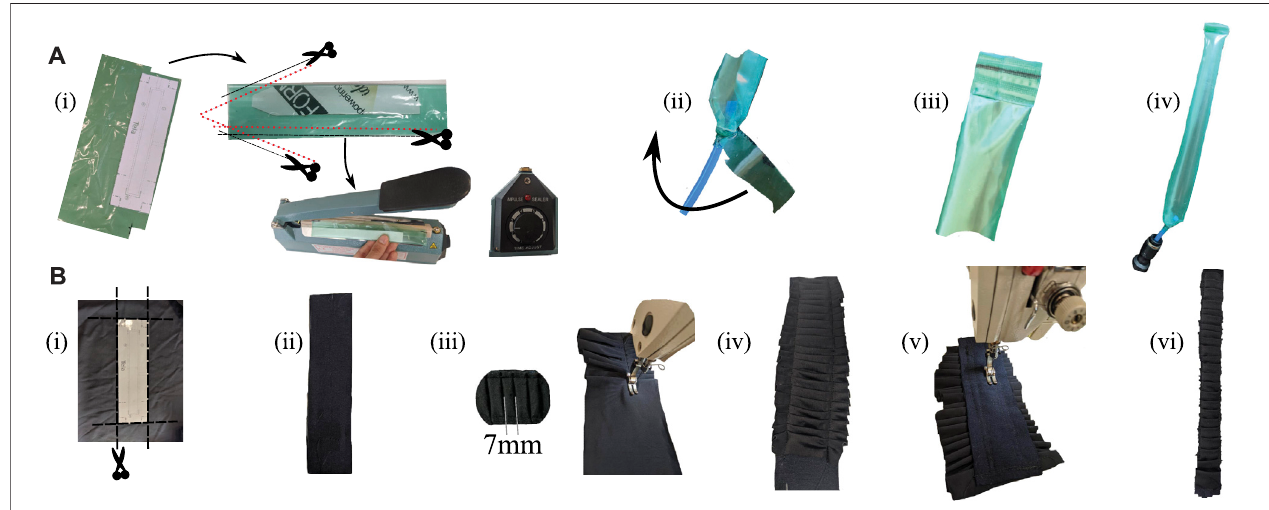
FIGURE3| Theconstructionprocessofatextileactuatorwithpleats. (A) Constructionoftheinternalballoonkeepstheairintheactuator; [(A),i] Cuttingtheplastic and sealing with the impulse sealer machine. [(A), ii] Placement of the plastic tube for in fl ation. At this point, plastic reinforcements are added to prevent leakage at the joint. [(A), iii] Sealing the end of the actuator several times to avoid leaks. [(A), iv] The pressurised balloon is shown. (B) Construction of the textile pocket with pleats; [(B), i,ii] Cutting the rigid and elastic fabric. [(B), iii] Joining the elastic fabric over the rigid one while making the pleats. [(B), iv] Pocket with pleats sewn on both